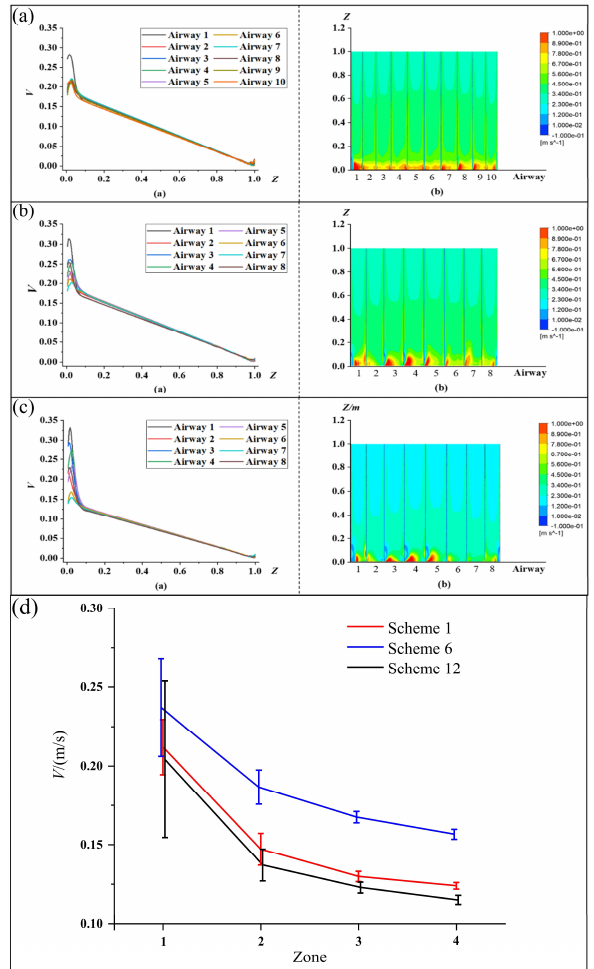
Figure 7. Gas velocity analysis of the fluidized bed airway. ( a – c ) Gas velocity attenuation curve and velocity field diagram of Scheme1, Scheme6, and Scheme12; ( d ) Standard deviation of velocity distribution for the three schemes.